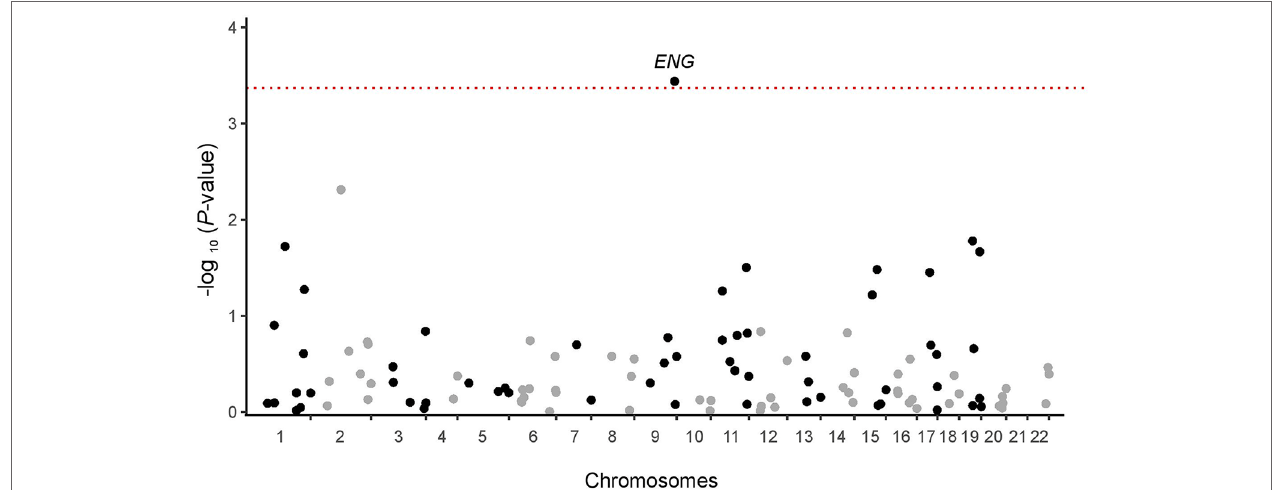
FIGURE 1 | Manhattan plot for the exome association analysis of 116 informative TGF- β pathway genes in the discovery cohort. The dotted red line represents the significance threshold after Bonferroni correction (p = 0.00043).